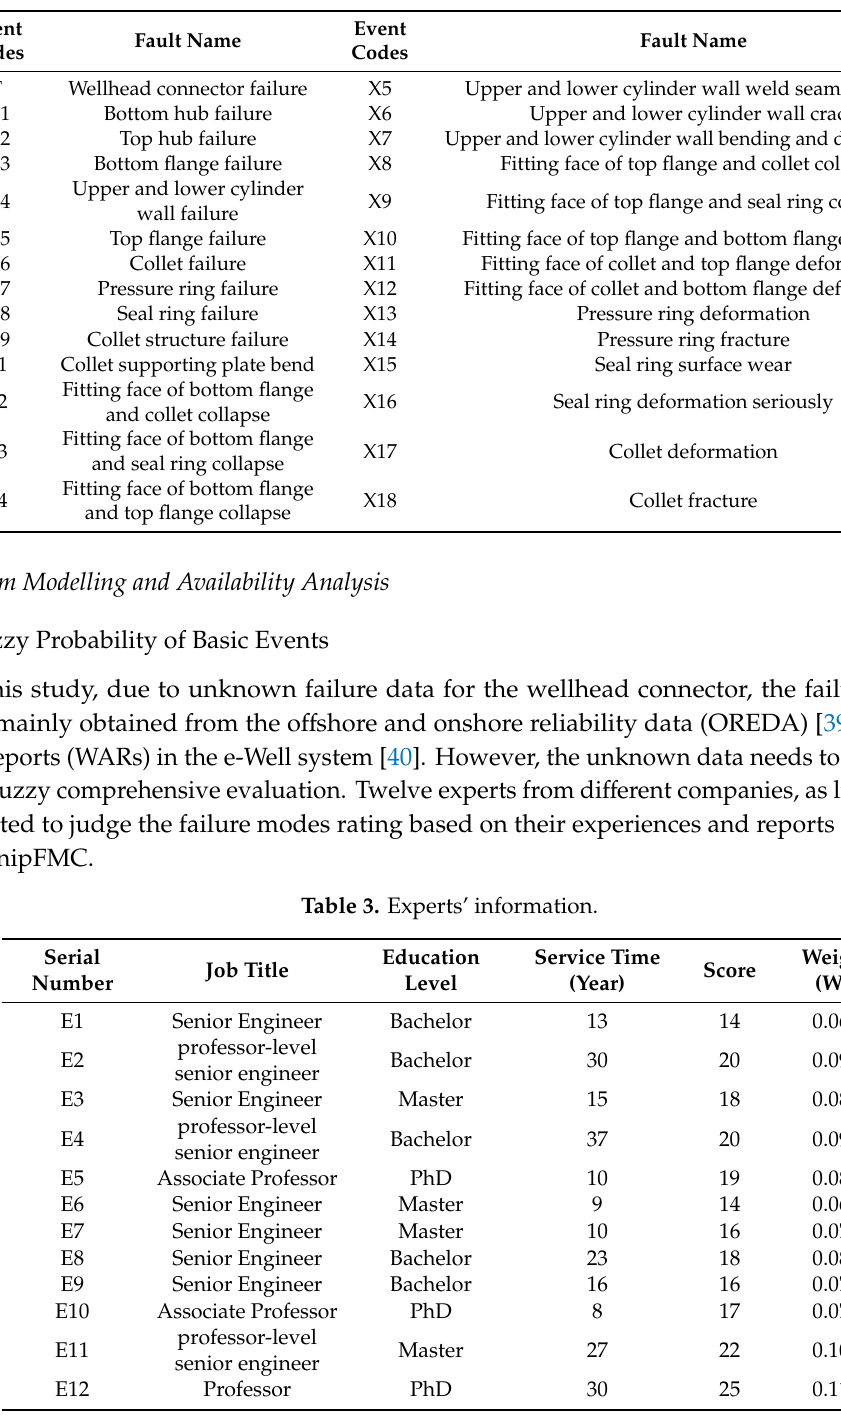
Table 2. Fault name of the basic events.